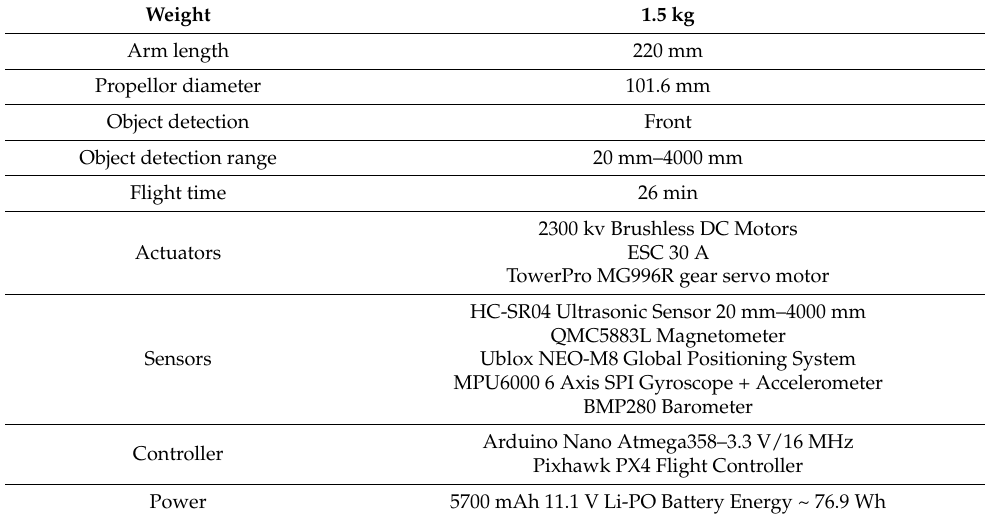
Table 4. Specification of Morphed MUAV.